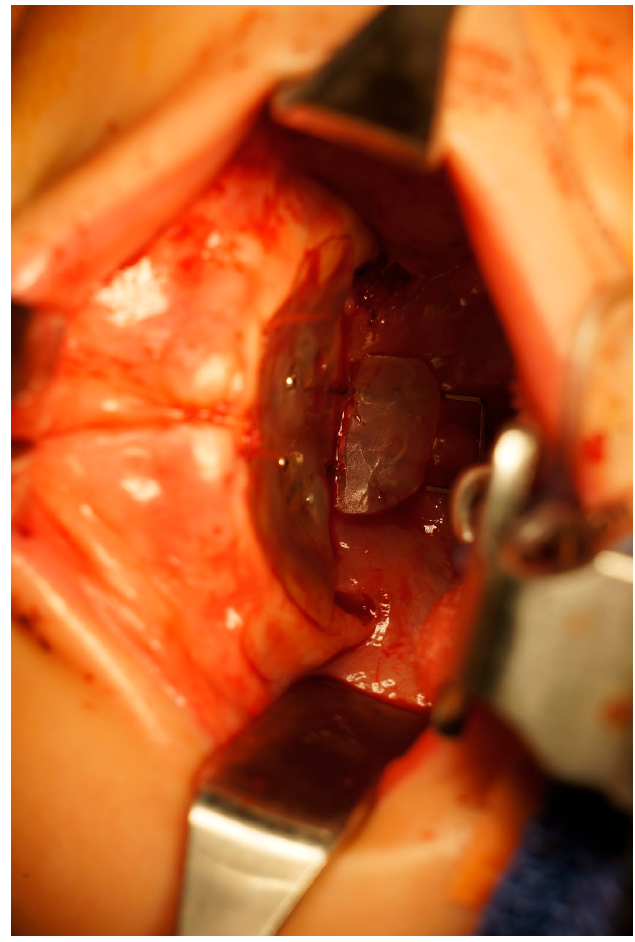
Figure 3. PPS fixated to the hard palate with the posterior extension covering the pharyngeal